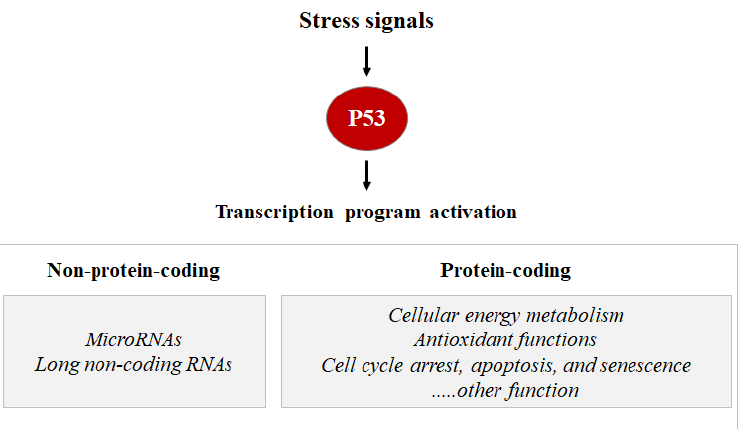
Figure 1. Stress signals can lead to P53 activation. Consequentially, the P53 can induce the transcription activation of coding proteins, ranging from the induction of cell cycle metabolism control, antioxidant functions apoptosis, senescence, cell cycle arrest, and DNA repair, or the P53 can induce the transcription activation of non-coding proteins such as microRNA and long non-coding RNAs.